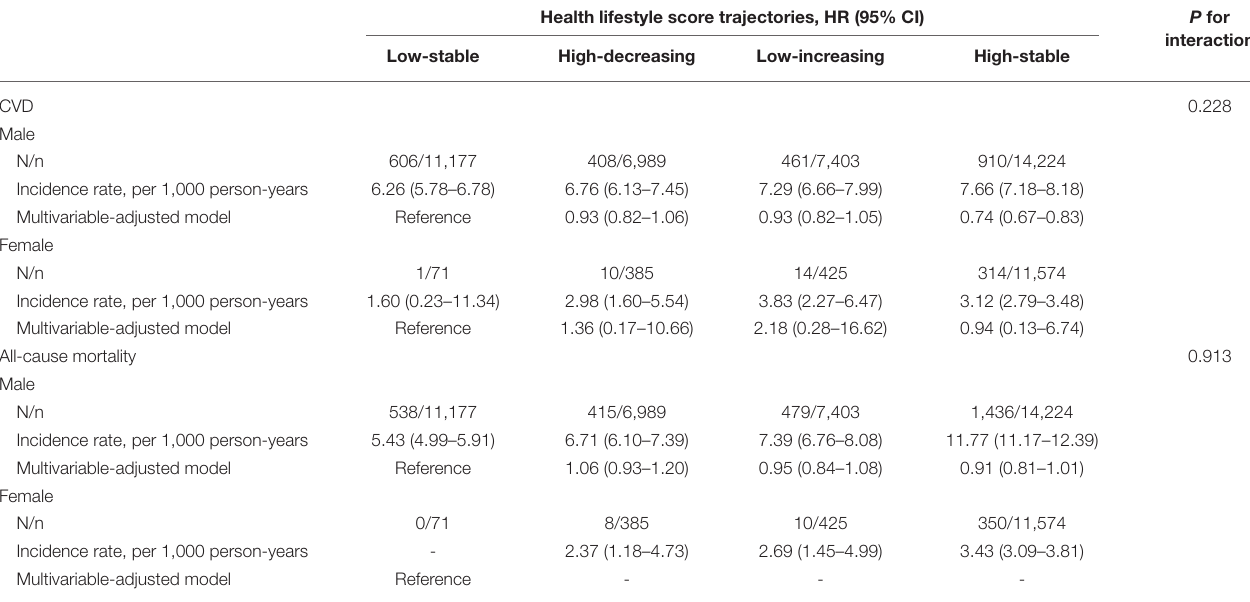
TABLE 3 | Stratified analysis of CVD and all-cause mortality according to sex.